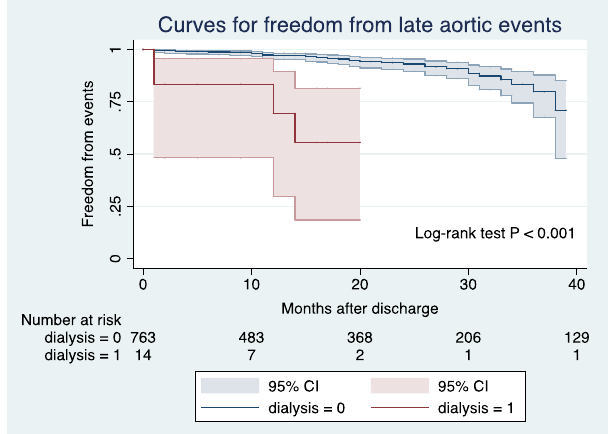
Figure 2. Kaplan–Meier curves for freedom from late aortic events of dialysis and non-dialysis patients suffering from acute type A aortic